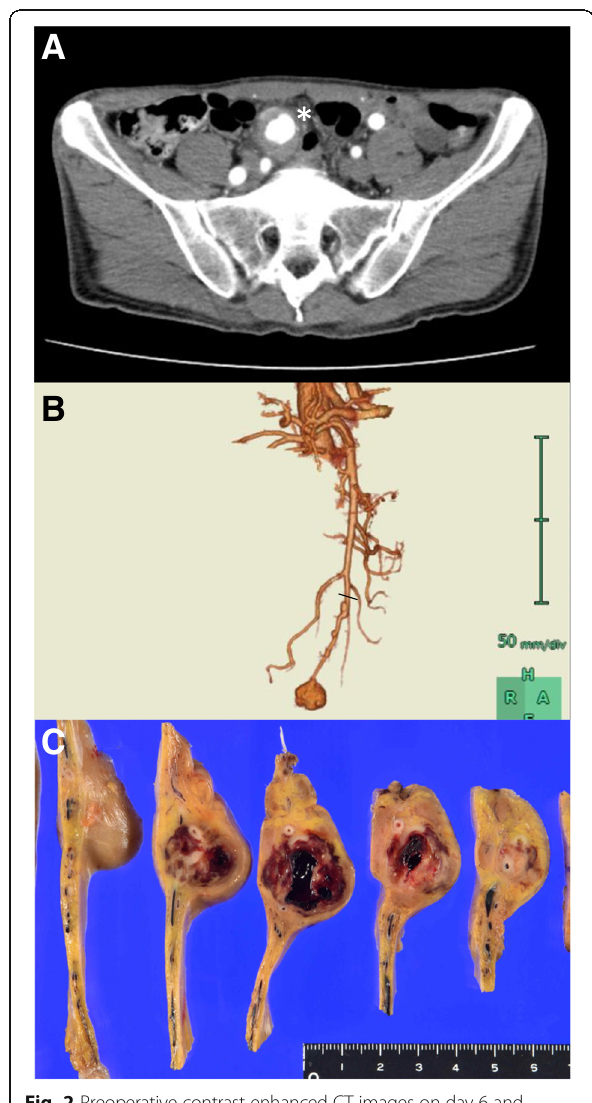
Fig. 2 Preoperative contrast-enhanced CT images on day 6 and photograph of resected specimen. a Aneurysm (white arrow) became larger in size, and its wall thickness became thinner, compared with the CT findings on admission. b CT angiograph revealed disappearance of SMA blood flow distal to the aneurysm that had been detected on CT angiograph on admission (Fig. 1c), strongly suggesting obstruction of the SMA distal to the aneurysm. Black line indicates the position